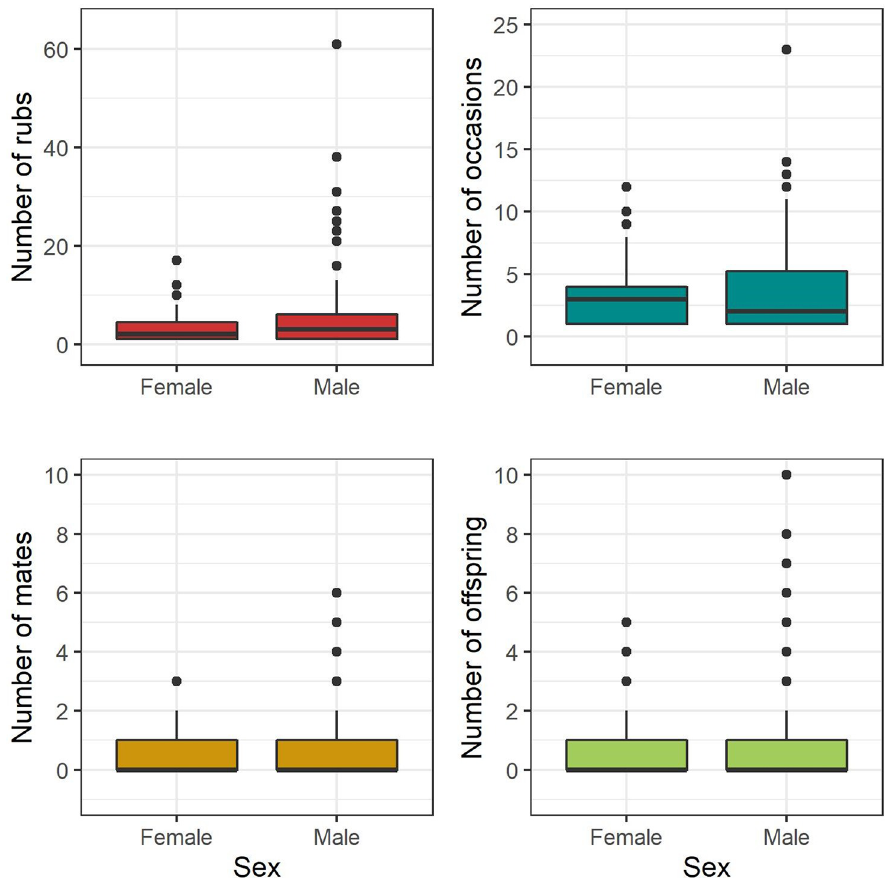
Fig 2. Summary plot. Summary plot of the number of rub objects at which and sampling occasions during which male and female brown bears were detected. Also displayed are the number of mates and offspring detected for each sex. Data are from southwestern Alberta